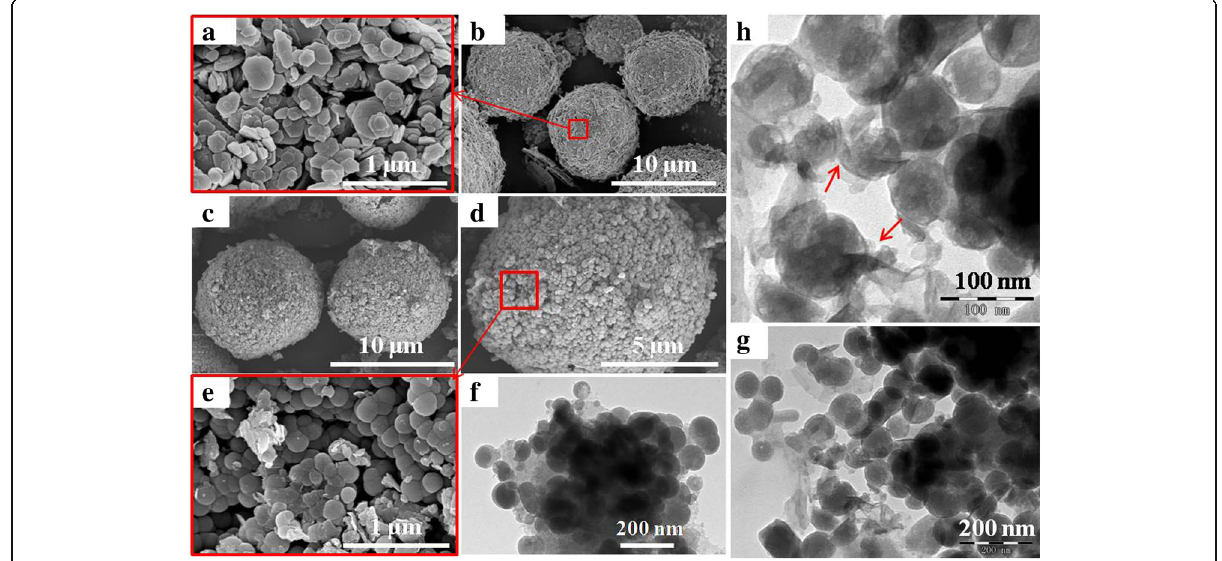
Fig. 2 SEM images of samples at different magnifications. a , b Kaol. c – e Hydrothermal treatment metakaolinite (PS-Kaol). f – h TEM images of